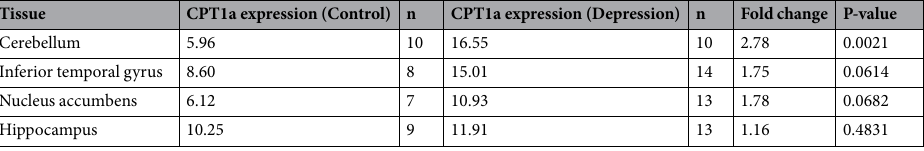
Table 1. mRNA expression of